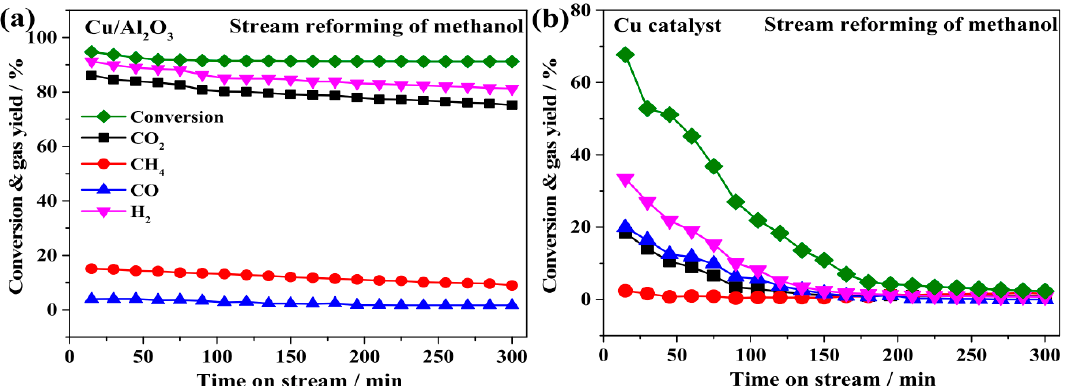
Figure 11. Time-on-stream tests (MSR) for Cu/Al 2 O 3 ( a ) and Cu ( b ) catalysts. Reaction conditions: S/C = 1.5; T = 500 °C; LHSV = 12.7 h − 1 ; P = 1 atm